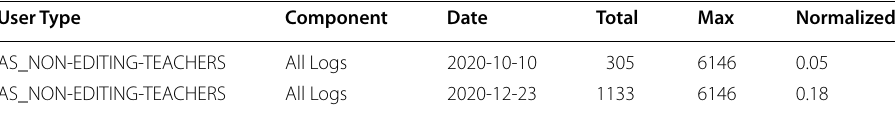
Table 1 Sample of collapsed data